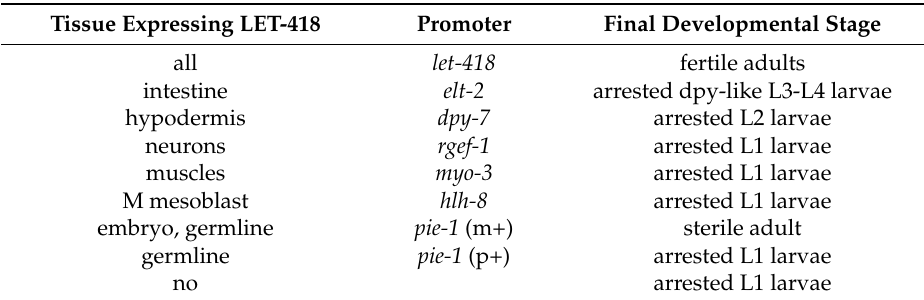
Table 1. LET-418 regulates L1 arrest cell non-autonomously.